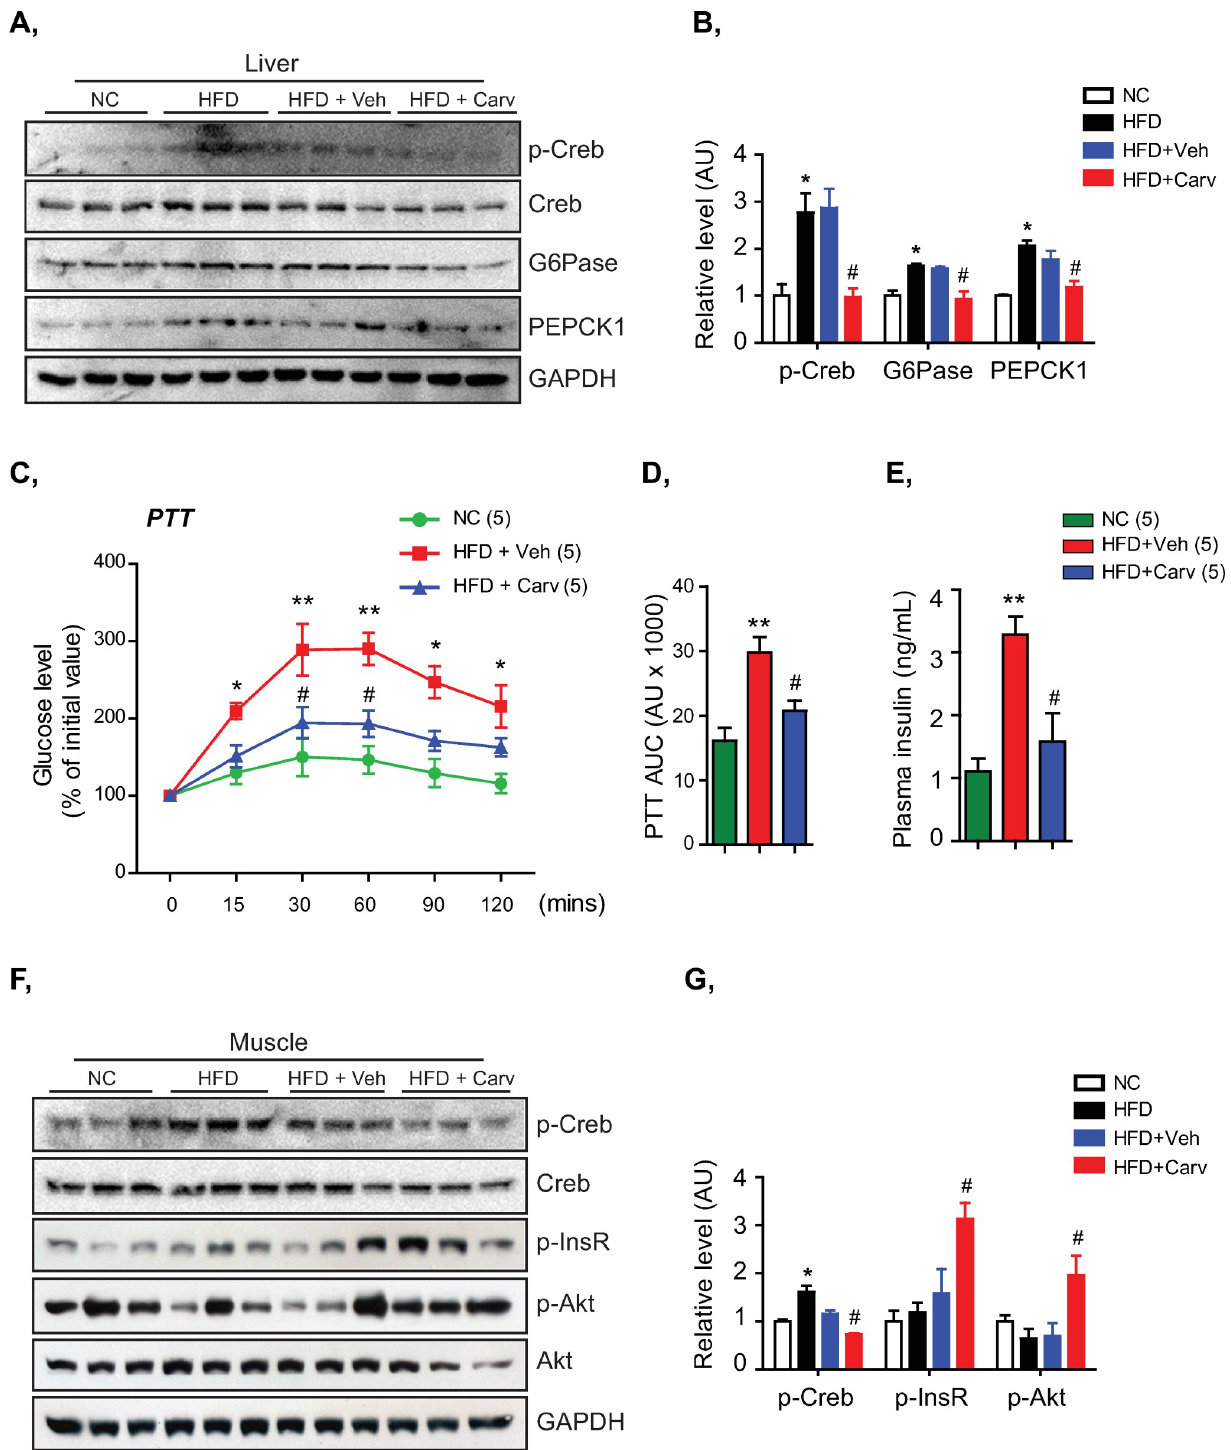
Fig 2. Carvedilol treatment attenuated the hepatic glucose overproduction and muscular insulin signaling impairment associated with the HFD- induced adrenergic overdrive. A, B, Immunoblots (A) and quantitative densitometry (B) showing the levels of p-Creb, G6Pase and PEPCK1 in the livers of NC-fed mice and HFD-fed mice treated with vehicle (Veh) or carvedilol (Carv). Normalized to total Creb or GAPDH. C, D, PTT (C) and PTT AUC (D) of NC-fed mice and HFD-fed mice treated with vehicle or carvedilol. E, Plasma insulin of NC-fed mice and HFD-fed mice treated with carvedilol or vehicle. F, G, Immunoblots (F) and quantitative densitometry (G) showing the levels of p-Creb, p-InsR and p-Akt in the muscles of NC-fed mice and